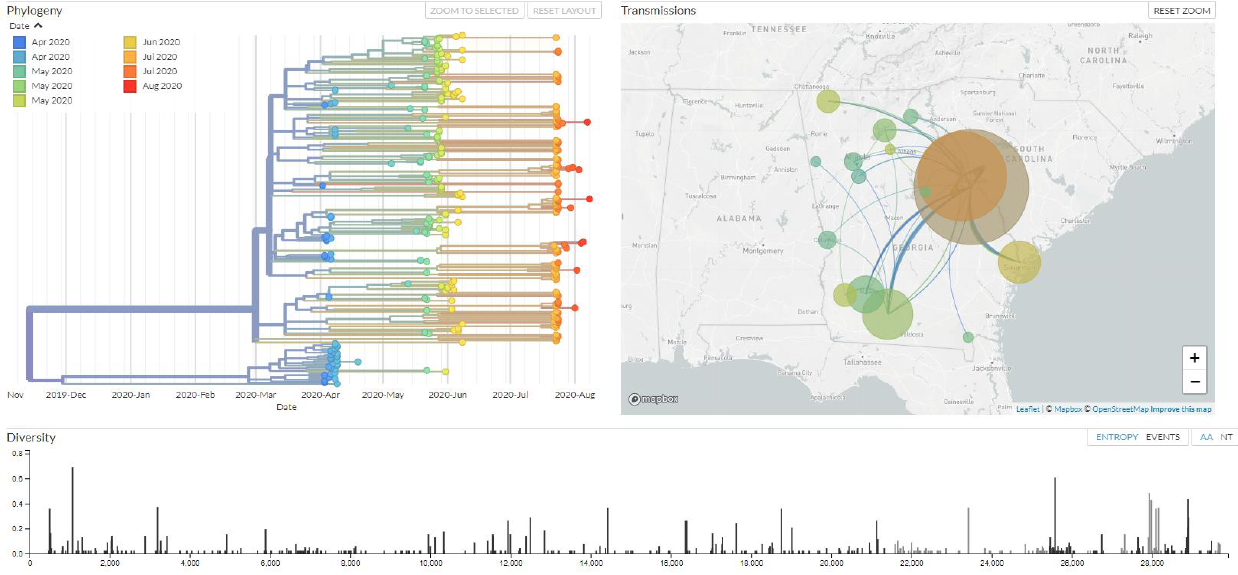
Figure 4. Nextstrain, interactive visualization of the phylogenic analysis of our SARS-CoV-2 isolates. (https://nextstrain.org/community/Bahl-Lab-IOB/SARS_CoV2_Augusta_Edu@main, 1 May 2021).